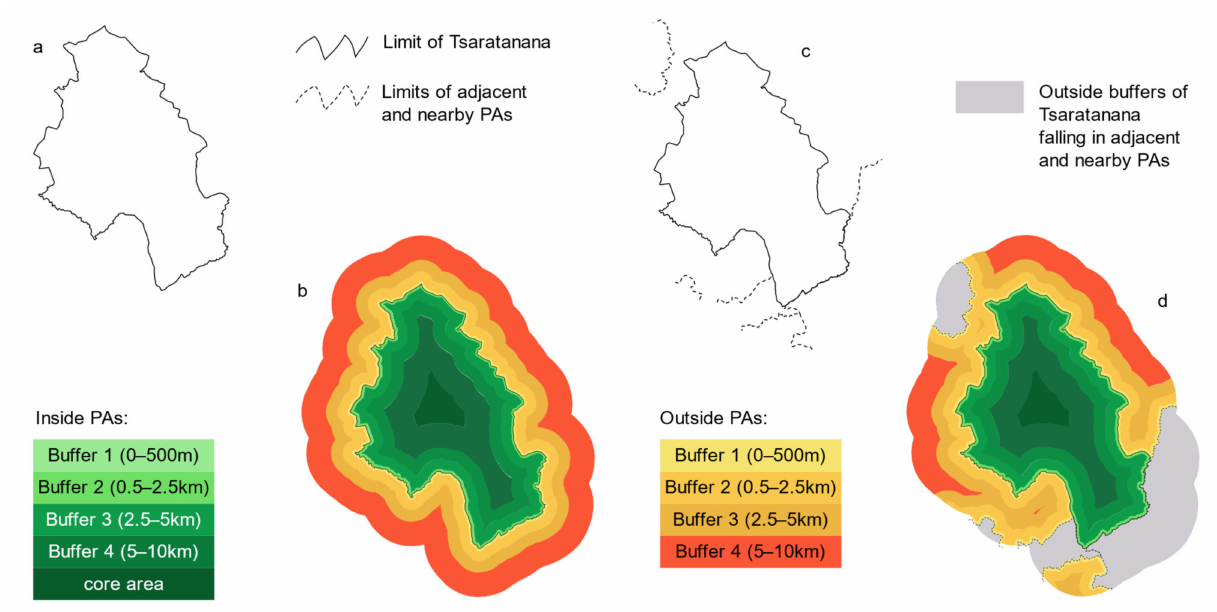
Figure 2. Four buffers and the core area inside the Tsaratanana PA, and the four reciprocal buffers outside. ( a ) limits of the PA in 2015; ( b ) buffers (inside/outside) according to distance to the limit; ( c ) limit of the Tsaratanana PA and limits of adjacent and nearby PAs in 2015; ( d ) final buffers when the PA is considered in the entire network of PAs, given that some outside buffers partly fall within other close PAs (grey), or in buffers closer to other